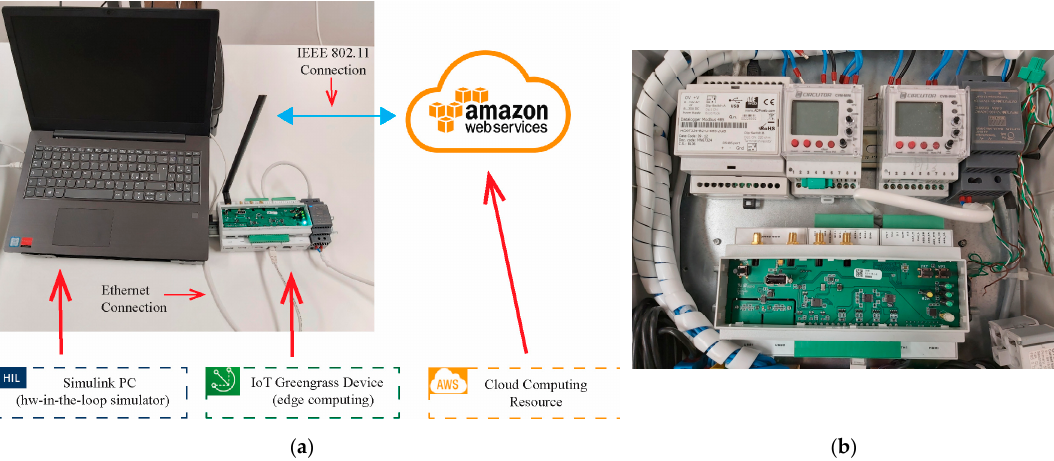
Figure 5. Photo of the experimental setup. ( a ) HIL setup for the validation of the proposed algorithm; ( b ) employed IoT device mounted in an industrial control and monitoring cabinet.